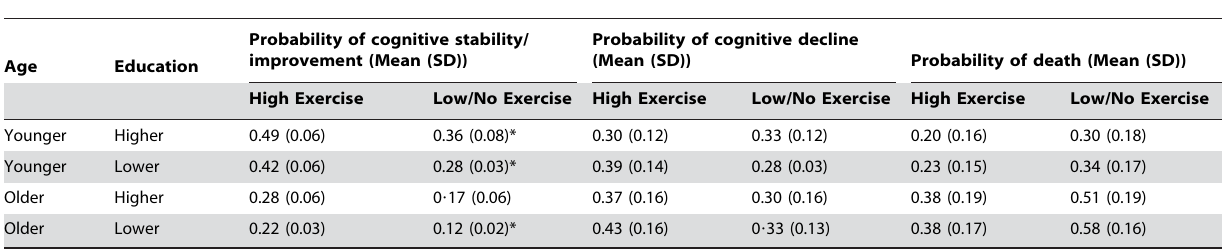
Table 2. Average probabilities (and standard deviation) of getting better or maintaining the same cognitive performance, cognitive decline or dying and their standard